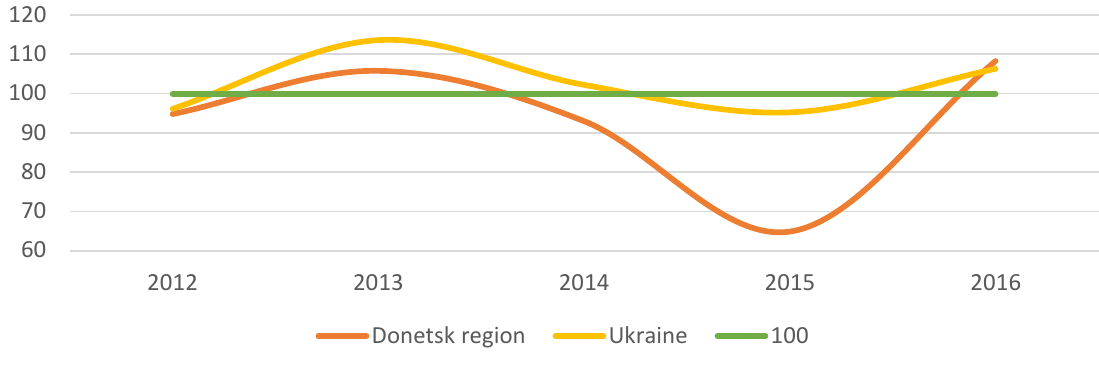
Figure 2. Dynamics of agricultural production indices for 2012–2016